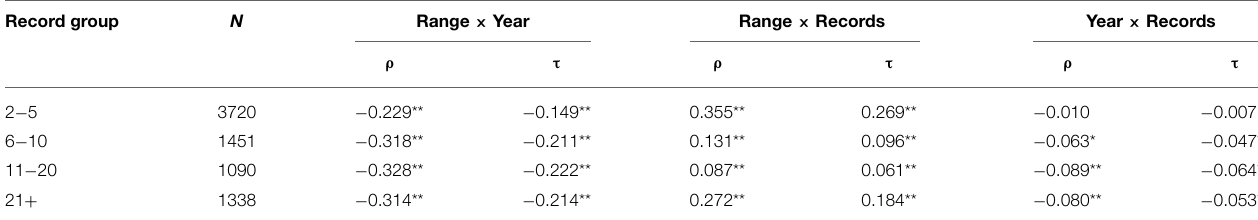
TABLE 2 | Correlations (Spearman’s ρ and Kendall’s τ ) between extent of occurrence, year described and number of records, for species grouped according to the number of records each has in the database. Record group